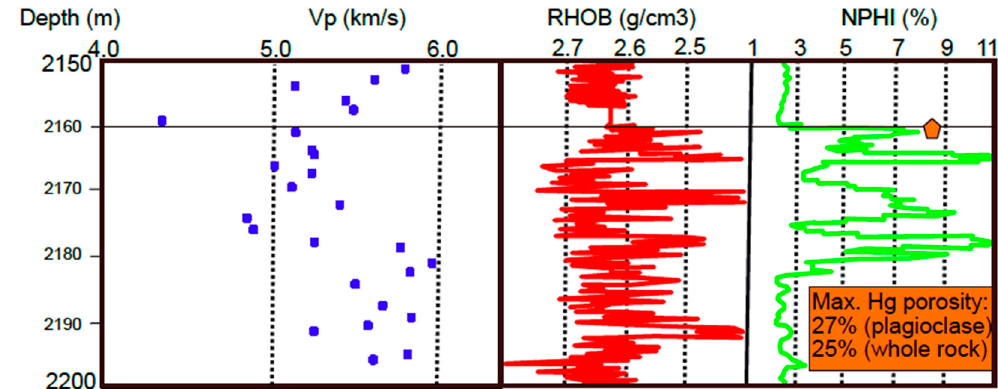
Figure 5. Parameters measured in borehole EPS ‐ 1: P wave velocity (Vp), density (RHOB) and neutron porosity (NPHI). The maximum porosity measured by mercury porosimetry (Hg porosity) is also given for two samples (whole rock and isolated plagioclase crystals) in the altered zone is highlighted by an orange pentagon (ca. 2160 m).